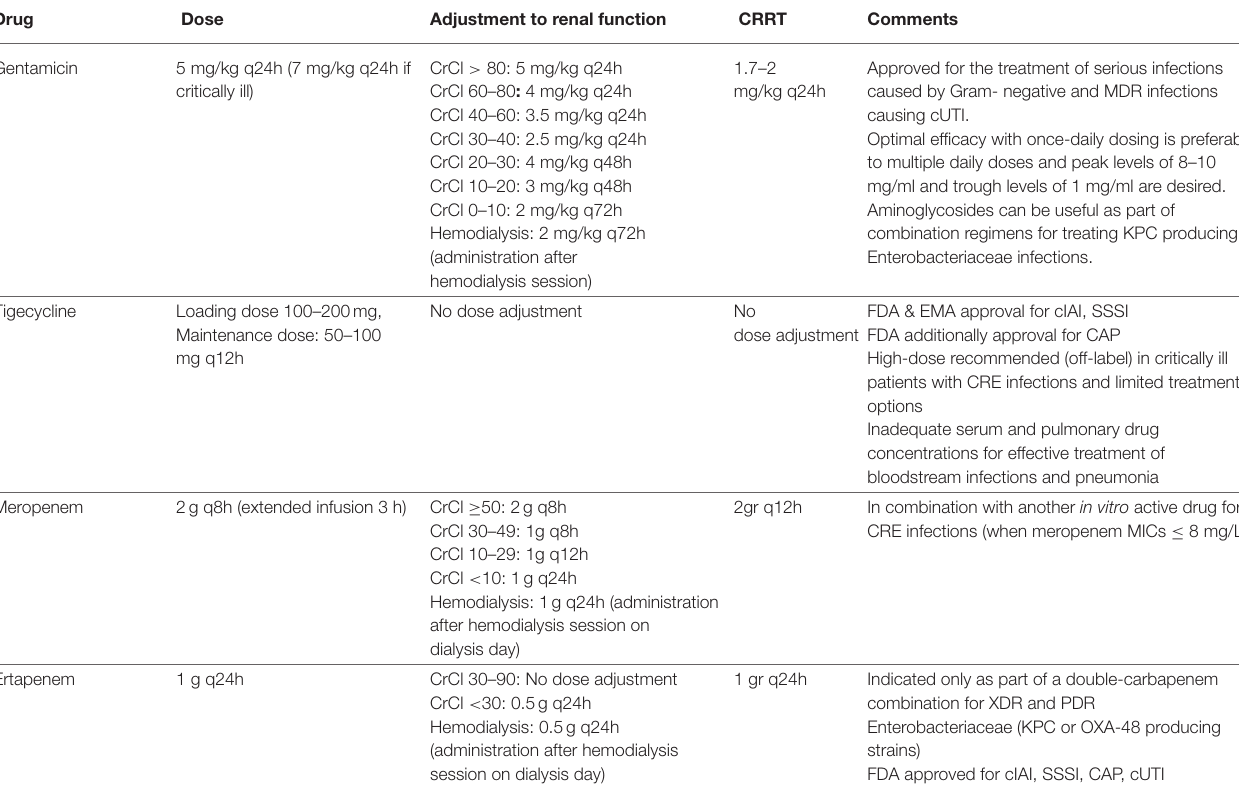
Drug Dose Adjustment to renal function CRRT